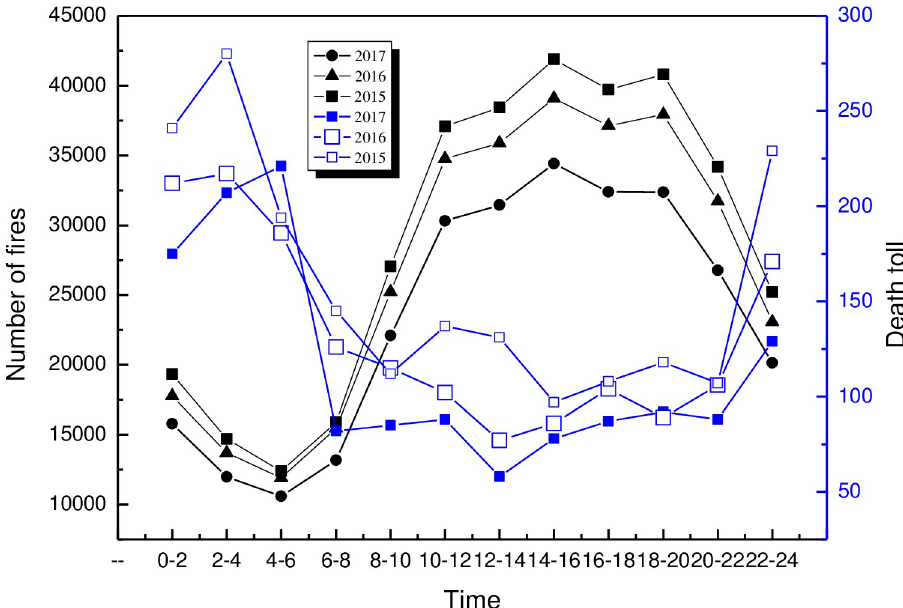
Fig 1. Fire frequency and death toll in 24 hours in China. From the perspective of 24-hour fire frequency in China, the fire frequency from 0 to 24 in 2015–2017 first showed decreasing from 0 to 6 and then increased slowly, and reached the peak between 14 to 20. Overall, the number of fires that occurred at 0–6 is at a low level within 24 hours. The trend of death toll is opposite to that of fire frequency. Taking 2017 as an example, a total of 38361 fires occurred from 0:00 to 6:00, with 603 deaths, with an average of 63 fires and 1 death. From 14:00 to 20:00, there were 99156 fires and 223 deaths, with an average of 444 fires and 1